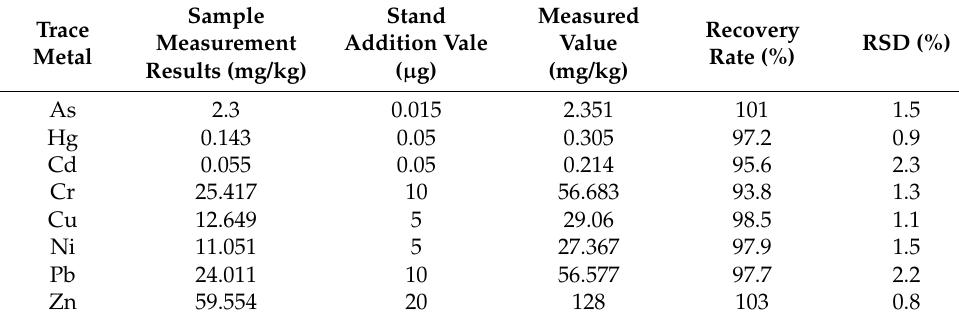
Table A7. Label recovery results